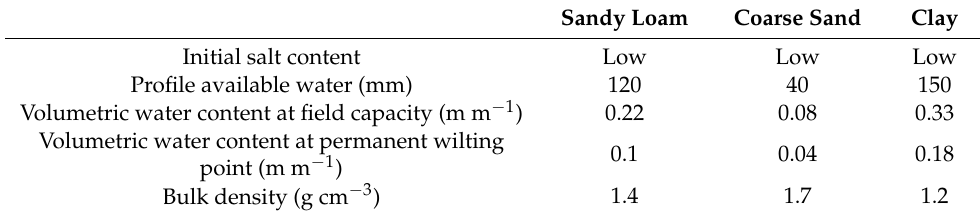
Table 2. Physical properties of the four contrasting soils used during the study [12]. Sandy Loam Coarse Sand Clay Initial salt content Low Low Low Profile available water (mm) 120 40